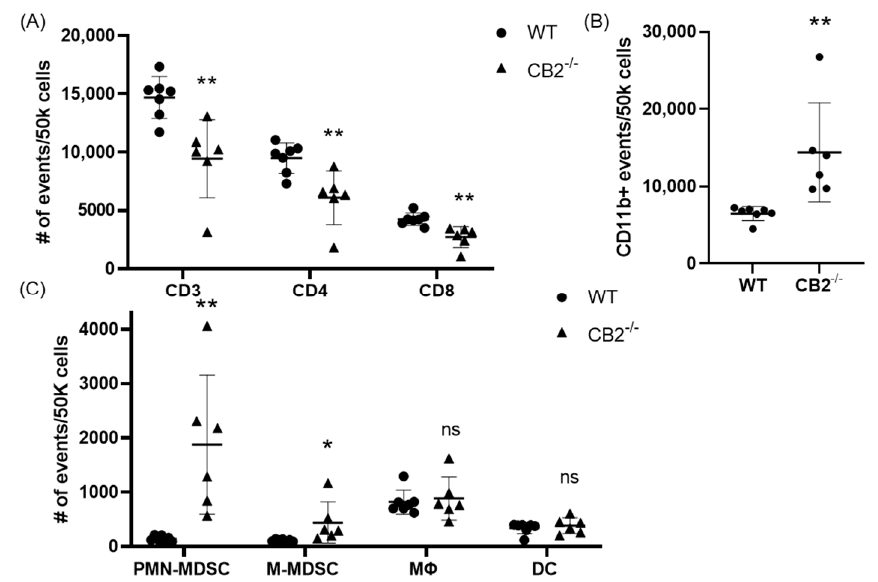
Figure 5. The CB2 receptor alters the balance between pro-tumor and anti-tumor cells in the spleen in mice receiving AOM/DSS. ( A ) Relative frequency of CD3+, CD3+CD4+, and CD3+CD8+ T cells in the spleen. ( B ) Relative frequency of CD11b+ and subpopulations of ( C ) CD11b+Ly6G hi Ly6C int (PMN-MDSC), CD11b+Ly6G-Ly6C hi (M-MDSC), CD11b+F480+ (macrophage, M Φ ), and CD11b hi Cd11c hi (DC). All of the values are expressed as the number of events per 50,000 cells, determined by flow cytometry. WT, n ≥ 7; CB2 − / − , n = 6. Student’s t -test, * p < 0.05 and ** p < 0.01; ns: not significant.